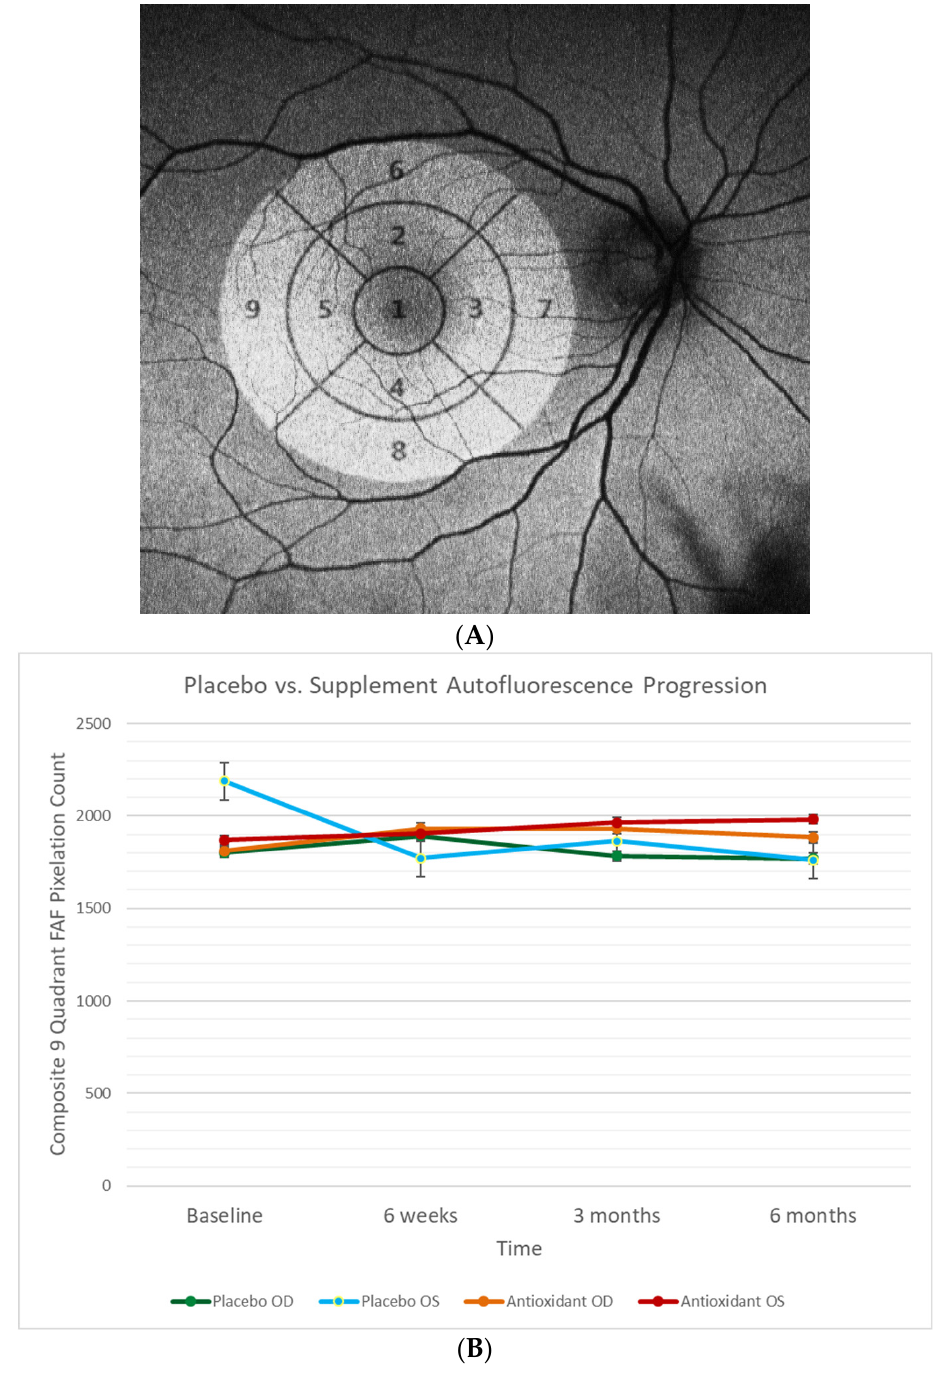
Figure 5. ( A ) Standard national eye institute ETDRS (early treatment of diabetic retinopathy) grid overlay on an OPTOS FAF image. ( B ) Nine quadrant composite pixilation count (placebo and active) over four time points, for OD (R eyes) and OS (L eyes). There was no significant difference between the active and placebo groups in either eye in terms of diminution of retinal auto fluorescence.